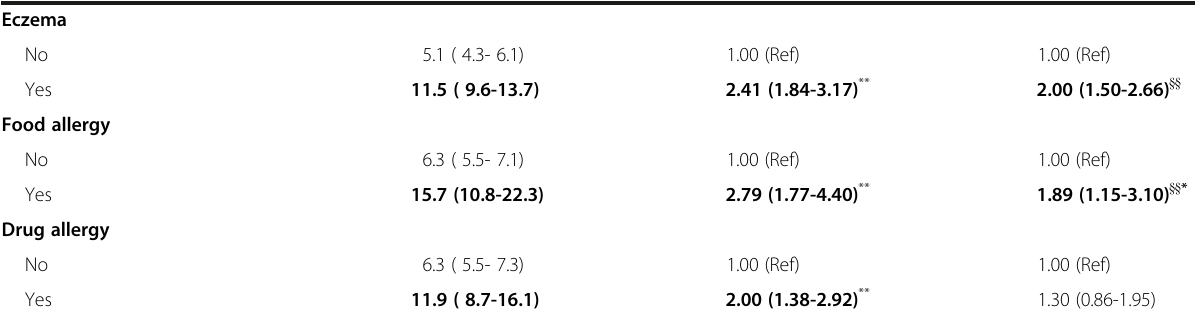
Table 2 Prevalence of ‘ Current asthma ’ and logistic regression models with crude and adjusted Odds Ratio (OR) (Continued)